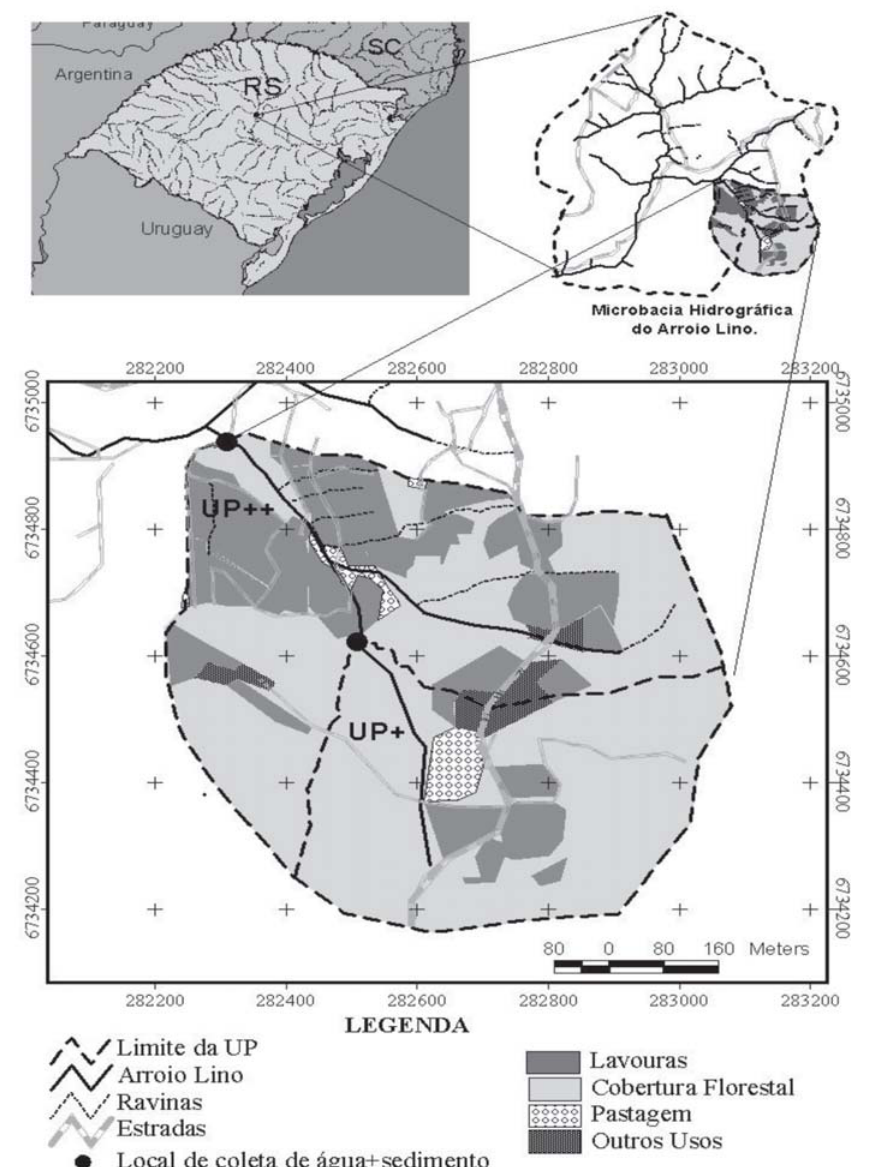
Figura 1. Pontos de coleta, divisores de água, sistemas de drenagem e uso do solo durante o ciclo de cultivo de fumo 2003/04 em duas unidades paisagísticas (UP), com diferentes graus de ação antrópica, de uma sub-bacia da pequena bacia hidrográfica do Arroio Lino, Agudo, RS.